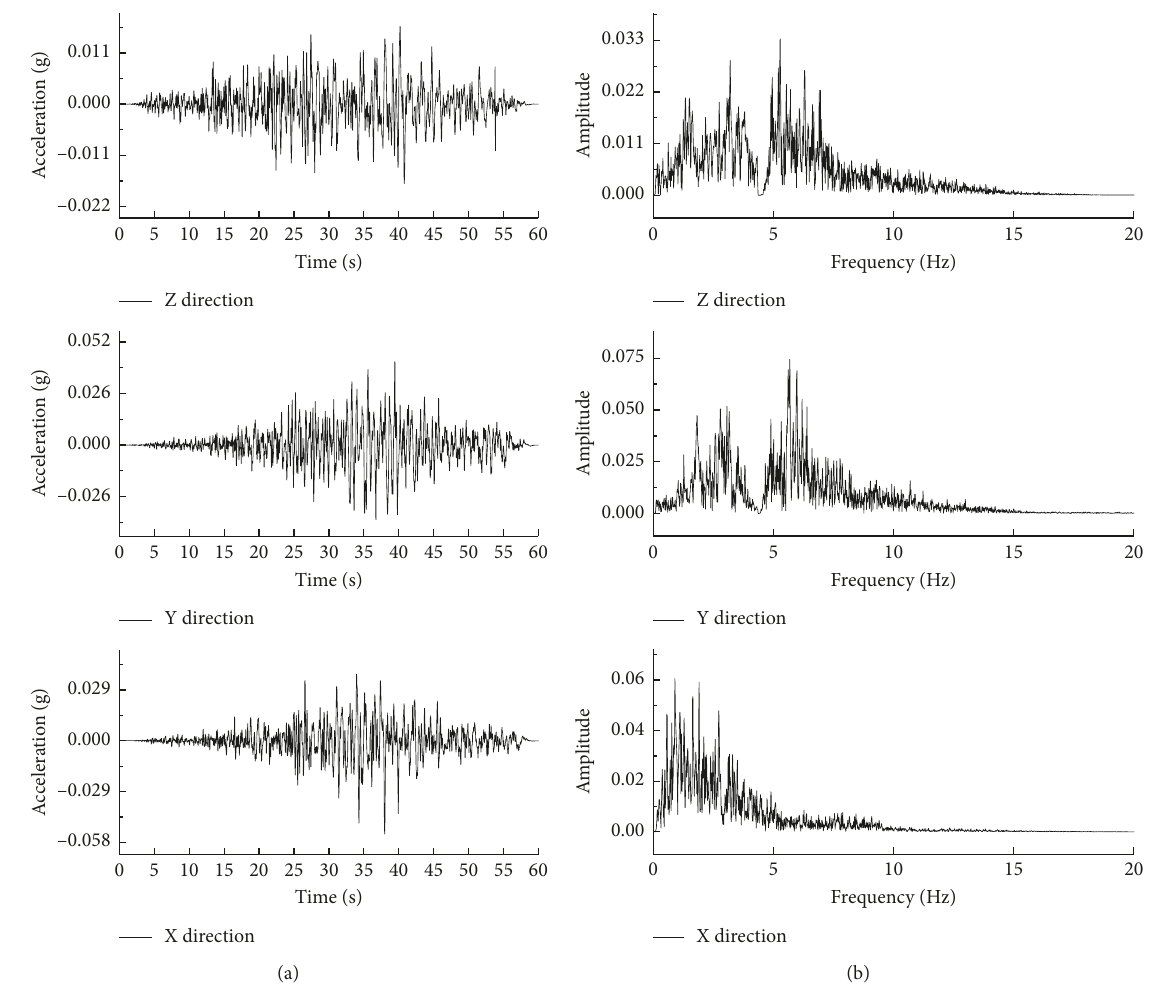
Figure 7: Acceleration time history and Fourier spectrum of records Chichi motions.